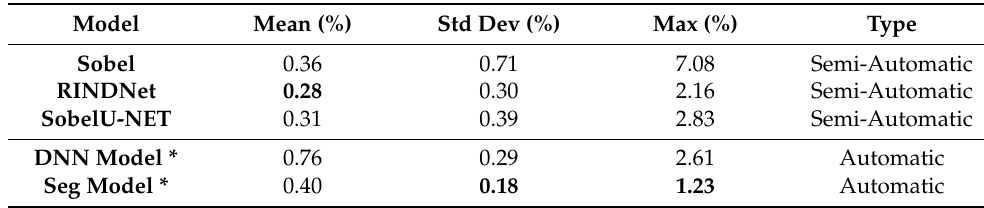
Table 1. Percentage of the mean, standard deviation and maximum error distance measured in pixels and standardized by the image diagonal. Results are for 5-fold-cross-validation on the mix dataset. Best results are highlighted in bold.